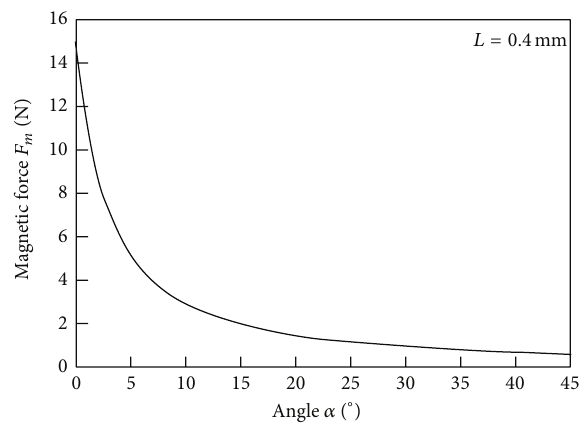
Figure 7: Relationship between magnetic force and tilt